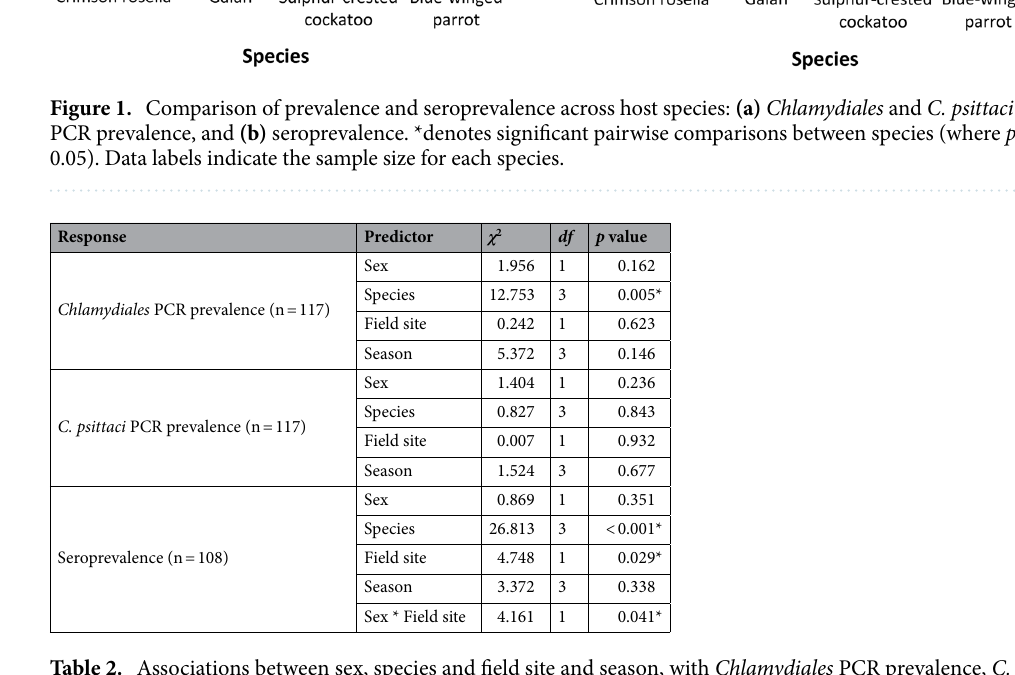
Table 2. Associations between sex, species and field site and season, with Chlamydiales PCR prevalence, C. psittaci PCR prevalence and seroprevalence. *denotes significance ( p < 0.05).